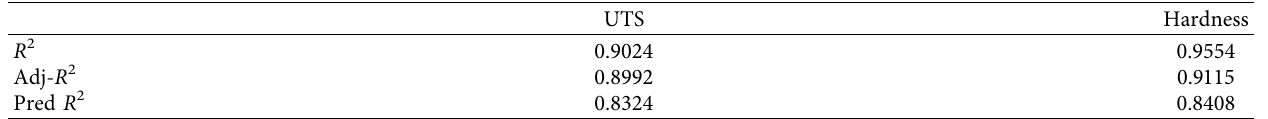
Table 5: Residuals for all the performance measures.